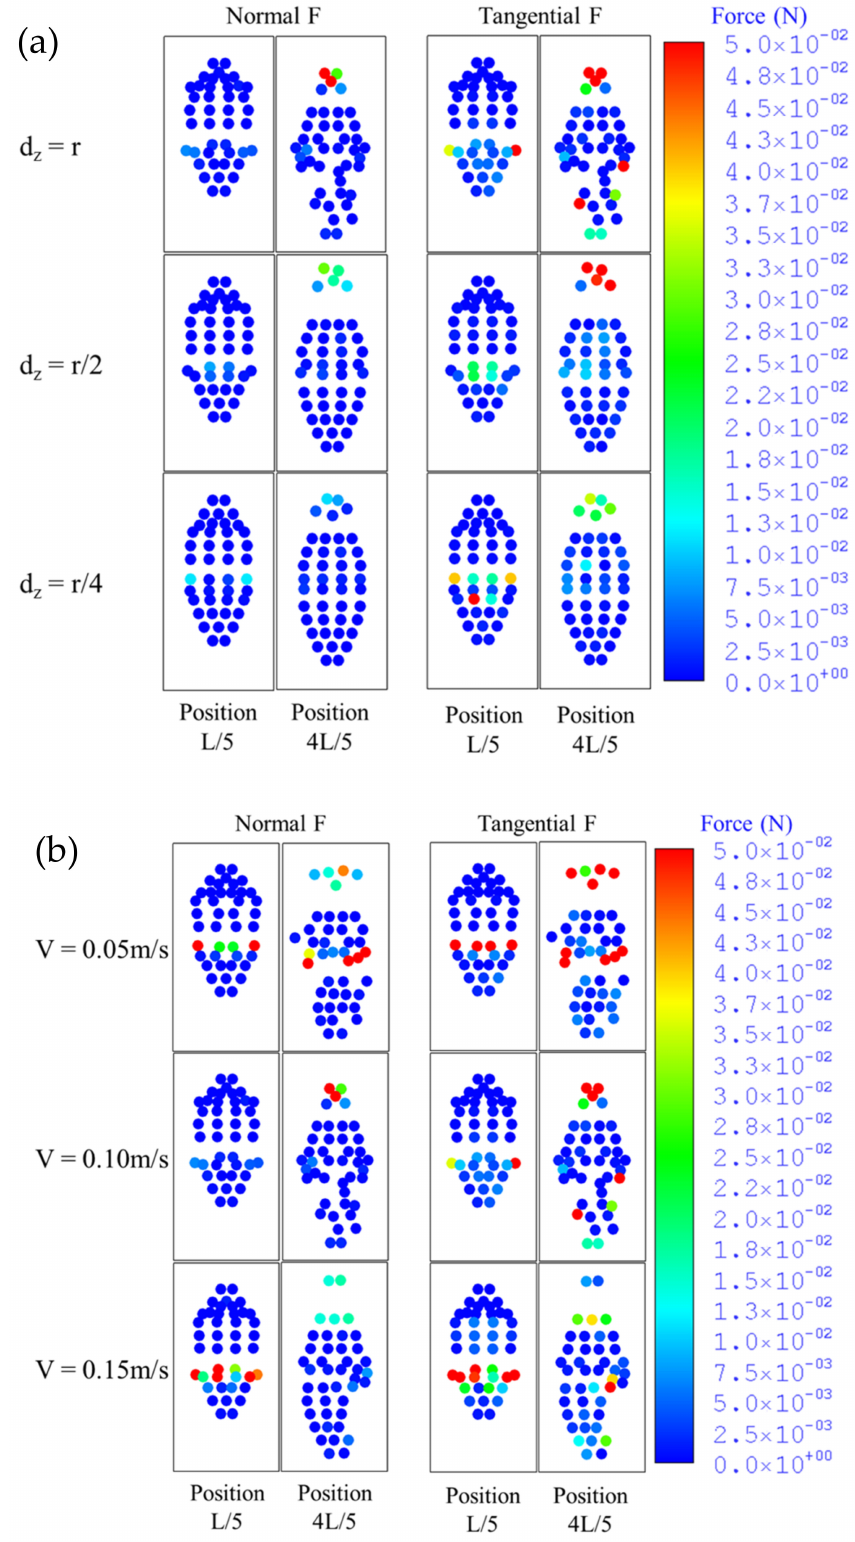
Figure 7. Contour plots of forces acting on toothbrush for ( a ) various toothbrush penetration depths at fixed toothbrush speeds ( V = 0.1 m/s) and ( b ) various toothbrush speeds at fixed toothbrush penetration depths ( d z = r )